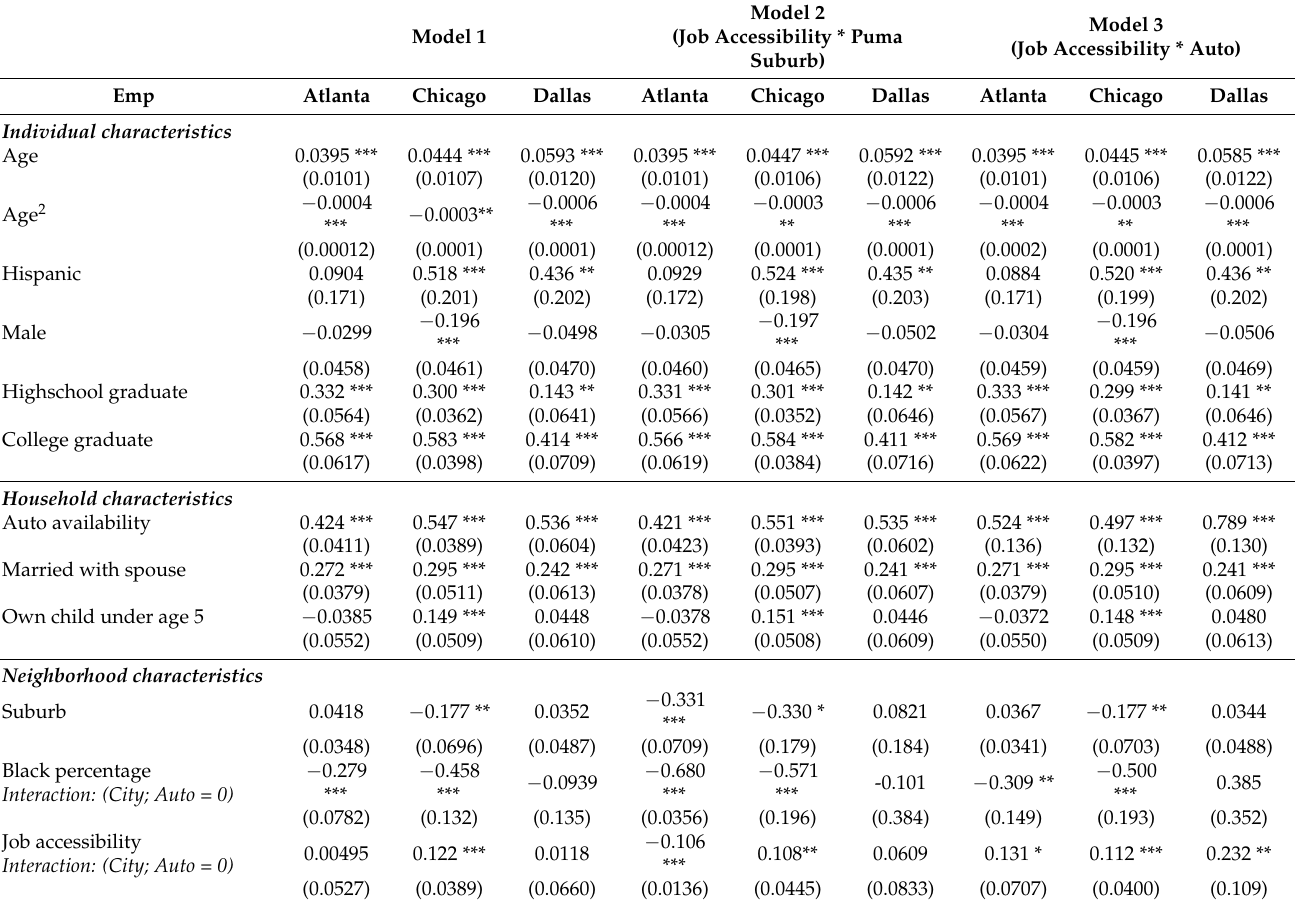
Table 2. Probit model results of employment outcomes.